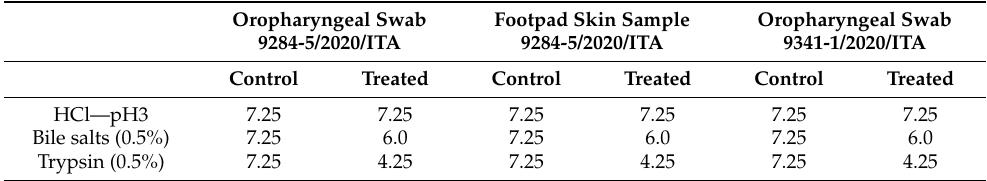
Table 3. Titre of FCV (log10 TCID50) and log10 reduction obtained after application of different